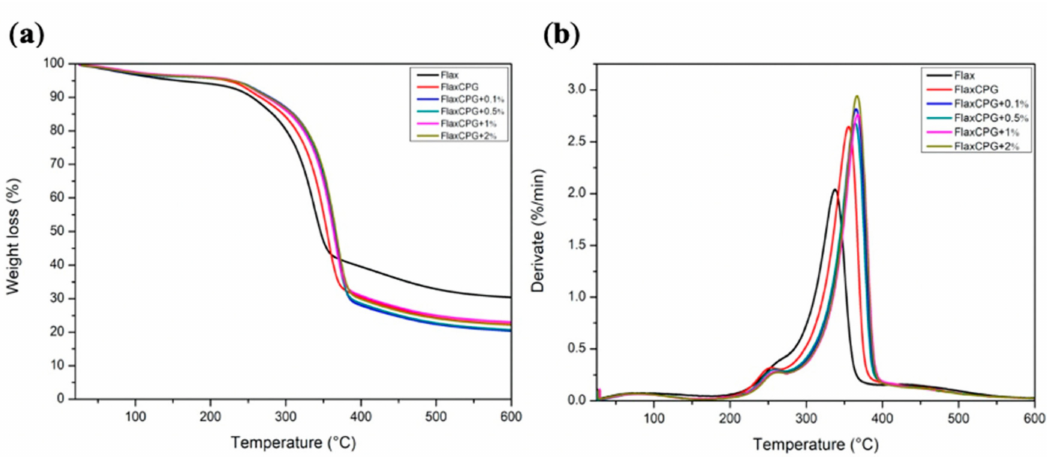
Figure 4. TGA ( a ) and DTG ( b ) curves of Flax, FlaxCPG and FlaxCPG with di ff erent percentages of